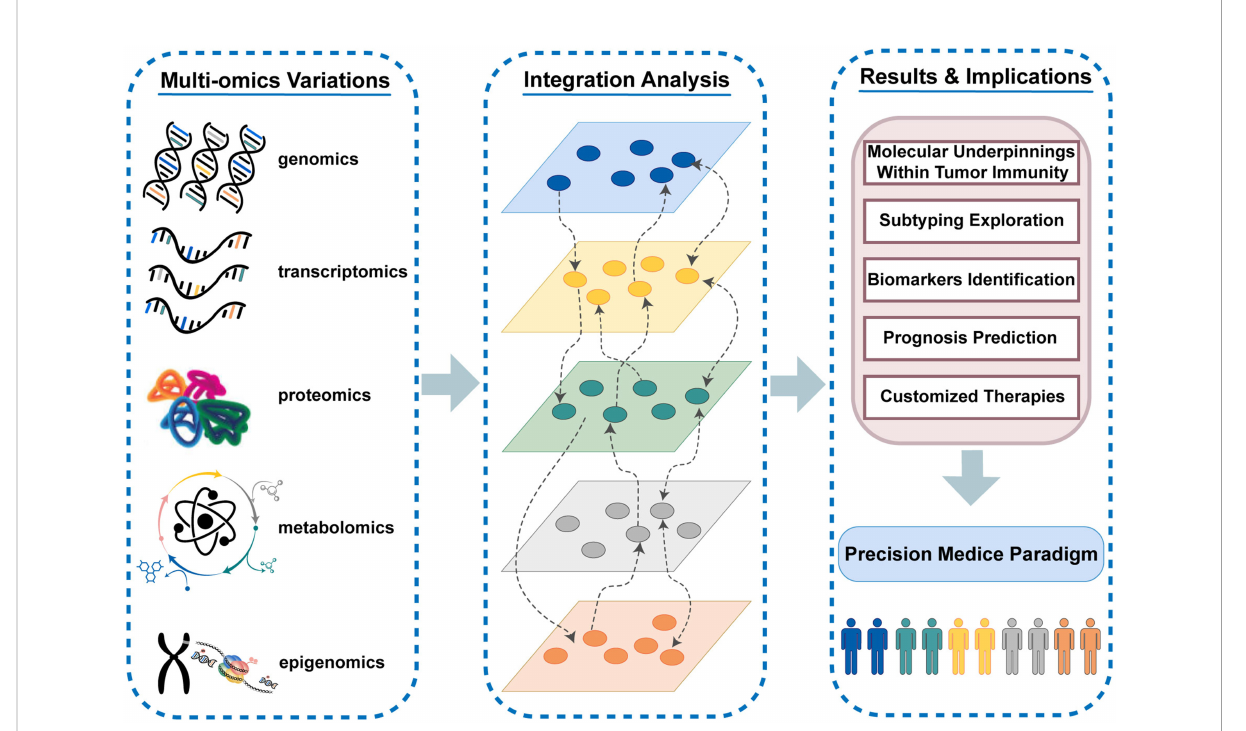
FIGURE 1 The highly dynamic and interactive multi-molecular layer systems and the vital role of multi-omics variants in tumor immunity and